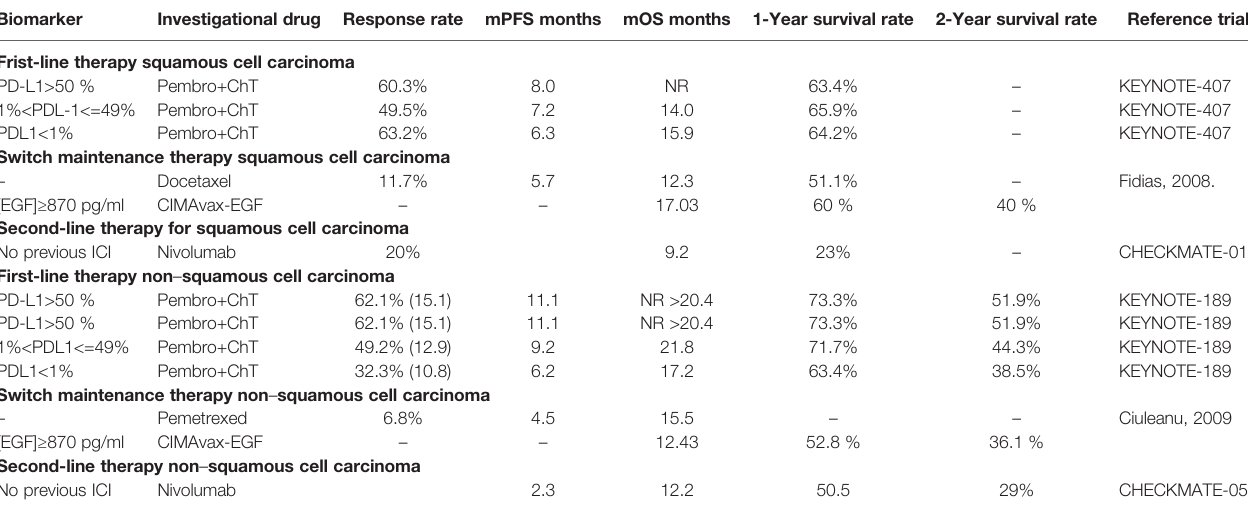
TABLE 2 | Most used therapeutic schemes in advanced NSCLC and no actionable mutations, according histology.